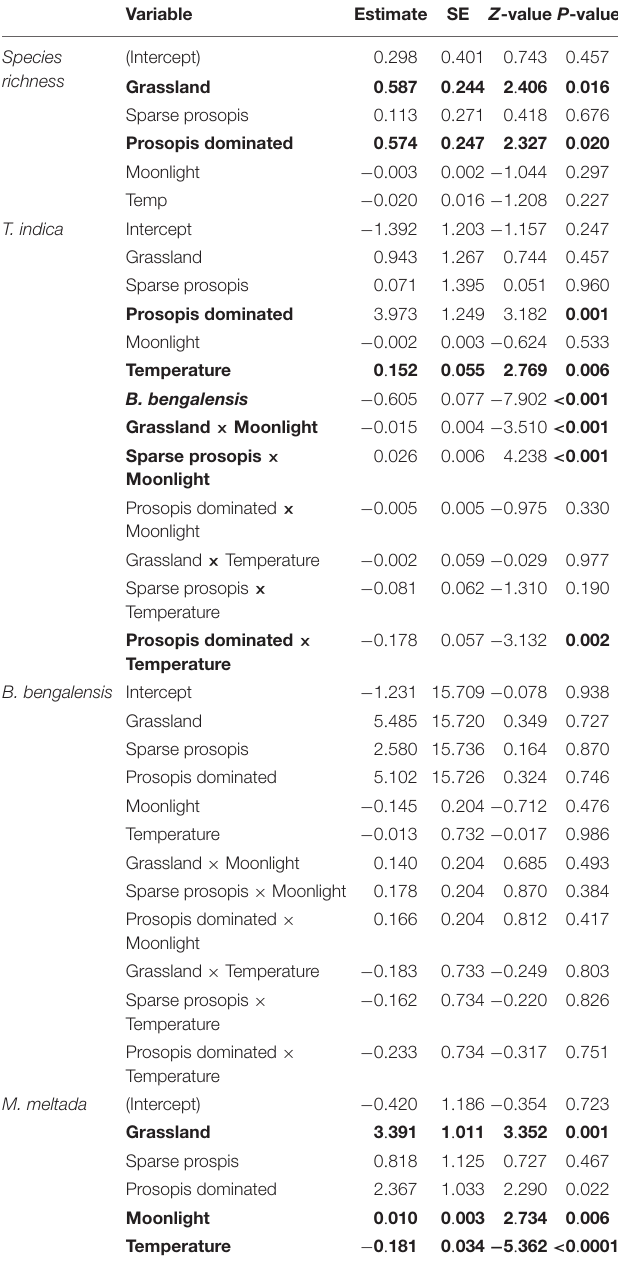
TABLE 5 | Results of generalized linear models (GLM) for species richness, measured as the total number of species captured on each sampling occasion, as well as the activity (total individuals captured at each sampling occasion) of T. indica , B. bengalensis, and M. meltada. Predictors for the Environment models included habitat type (agricultural fallow was taken as the reference level), moonlight conditions, and minimum nighttime